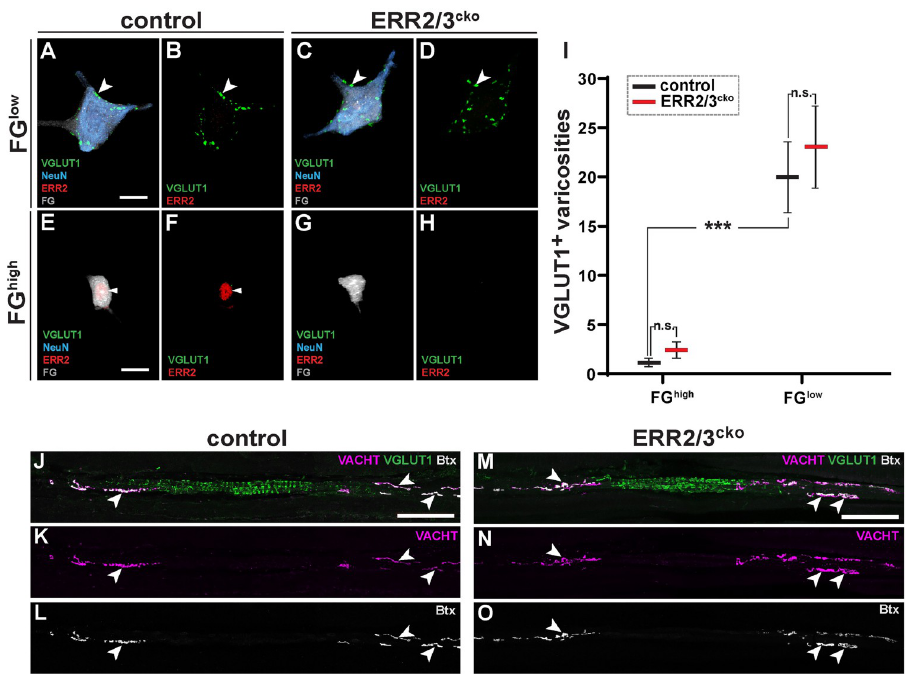
Fig 4. Generation of distinguishable gamma motor neurons in the absence of ERR2/3. (A-I) Imaris 3D reconstruction: VGLUT1 + synaptic varicosities (green) associated with large FG low , NeuN high motor neurons in control (A, B) and ERR2/3 cko mice (C, D) (scale bar: 20 μ m). (E-H) Absence of VGLUT1 + puncta on FG high , NeuN low motor neurons in control (E, F) and ERR2/3 cko mice (G, H) (scale bar: 20 μ m). (I) Significant difference in VGLUT1 + varicosities associated with FG high , NeuN low and FG low , NeuN high motor neurons from control mice. Lack of significant differences in VGLUT1 + synaptic varicosities associated FG low , NeuN high motor neurons in control (20 ± 3.48, n = 9) versus ERR2/3 cko mice (23.1 ± 4.06, n = 10). Lack of significant differences in VGLUT1 + varicosities between control FG high , NeuN low (1.1 ± 0.36, n = 10) and ERR2/3 cko FG high , NeuN low motor neurons (2.4 ± 0.78, n = 10). (J-O) P300 mouse extensor digitorum longus (EDL) muscle spindles of control (J-L) and ERR2/3 cko (M-O) mice. (J-L) Distribution of Ia sensory annulospiral endings in the central spindle segment (visualized by VGLUT1, green), motor innervation (VACHT, magenta) and their postsynaptic sites (arrowheads) on intrafusal fibers (BTX, alpha bungarotoxin, grey) (scale bar: 100 μ m). (K-O) Normal appearance of ERR2/3 cko muscle spindles, including Ia sensory annulospiral endings and motor innervation of BTX + postsynaptic sites (arrowheads) on intrafusal fibers (scale bar: 100 μ m). Data are presented as mean ± SEM. n = # of neurons. Statistically significant differences control and ERR2/3 cko motor neurons are indicated as: � p < 0.05, �� p < 0.01, ��� p < 0.001, n.s. = not significant, Student t test). Data for Fig 4I can be found in S2